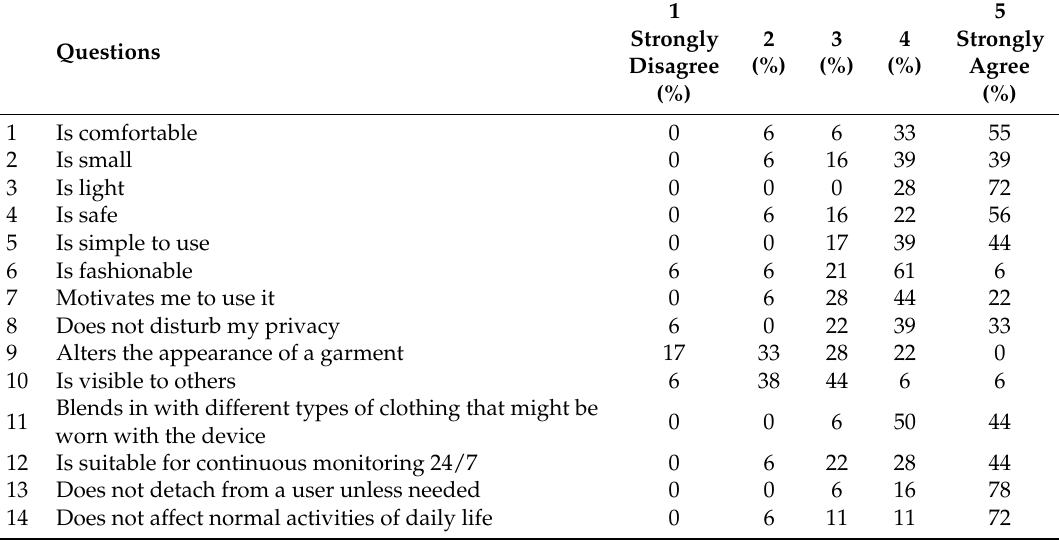
Table 5. Percentages for responses to 14 usability questions for the STS.